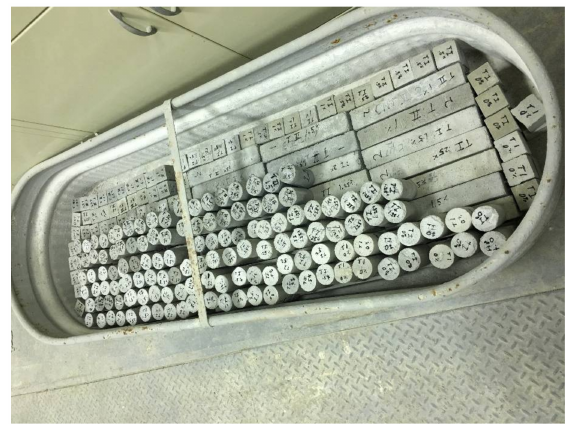
Figure 2. Curing LMM specimens inside the water